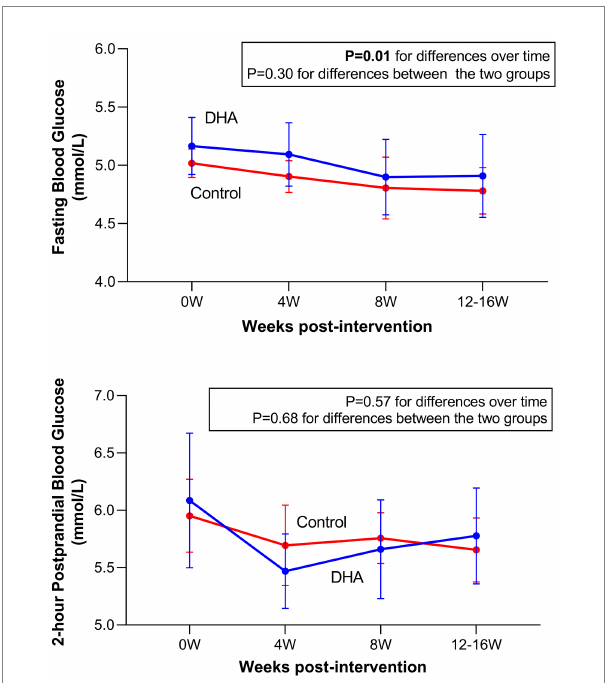
FIGURE 1 Fasting and 2-h postprandial blood glucose concentrations (mean ± 95% CI) at 0, 4, 8, and 12–16 weeks post-intervention in women with gestational diabetes mellitus (GDM) in docosahexaenoic acid (DHA) supplementation and control groups.